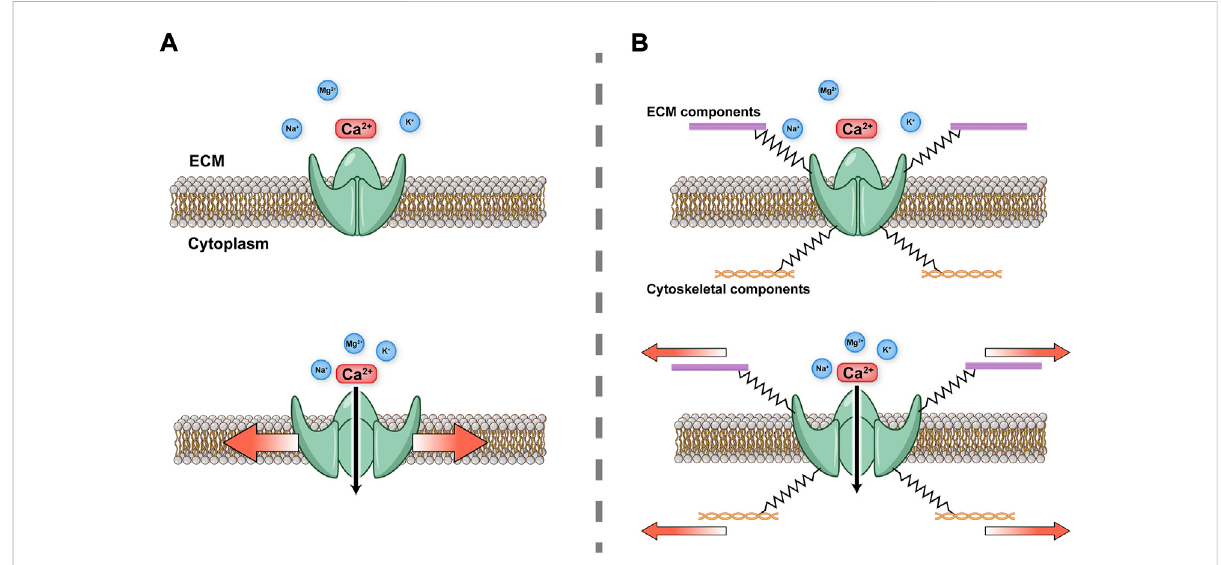
Schematic diagram of Piezo gating modes (A) Force-from-lipids. Mechanical force activates Piezo channel through the lipid bilayer. (B) Force- from- fi laments. Force acts on cytoskeleton and extracellular matrix (ECM) tethering to the Piezo